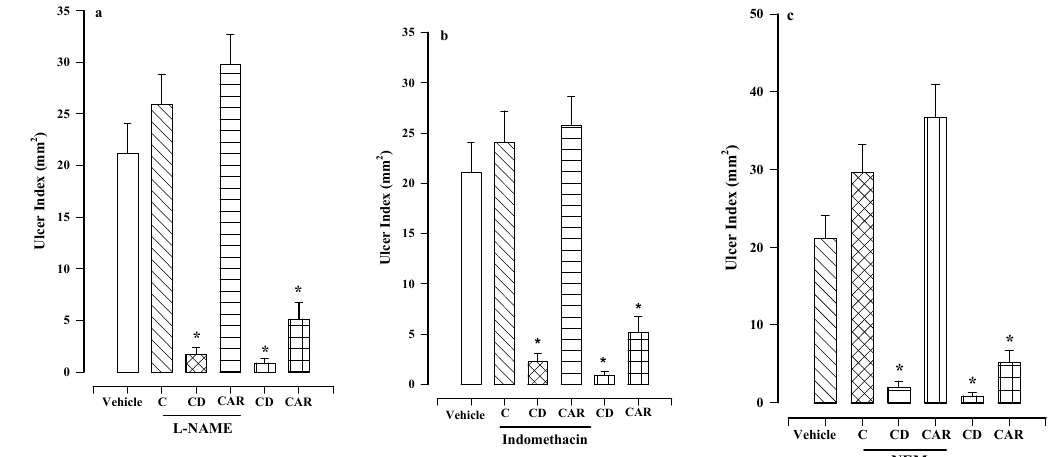
Figure 3. Effect of calein D (CD) and carbenoxolone (CAR) on gastric lesions induced by ethanol in mice pretreated with N G -nitro- L -arginine methyl ester ( L -NAME) (70 mg/kg) ( a ), indomethacin (10 mg/kg) ( b ) or N -ethylmaleimide (NEM) (10 mg/kg) ( c ). C = the control group for the distinct inhibitors. Bars represent the mean ± SEM ( n = 7). * p < 0.05 vs. the respective control, based on the Kruskal − Wallis test followed by Dunn’s multiple comparison.